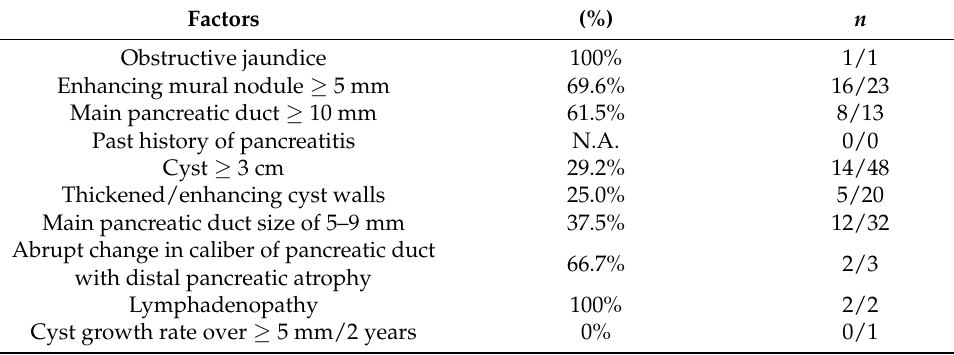
Final Diagnosis Malignant Total ( n ) IPMN ( n ) IPMN ( n ) HRS 11 WF NR 45 0 45